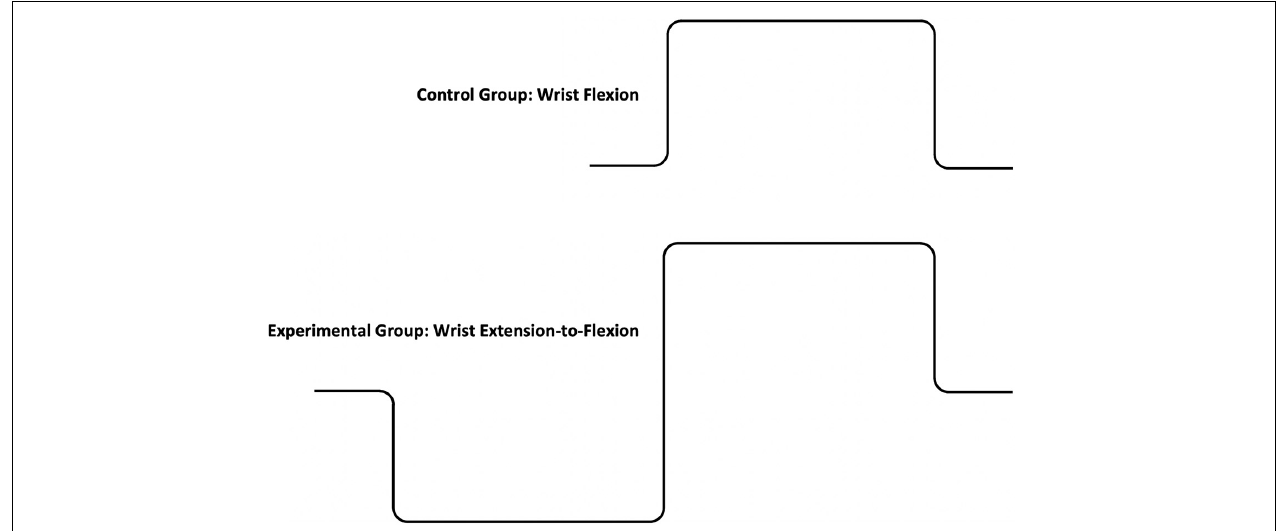
FIGURE 1 | The ideal torque-time curves shown to participants in the control group (top panel) and the experimental group (bottom